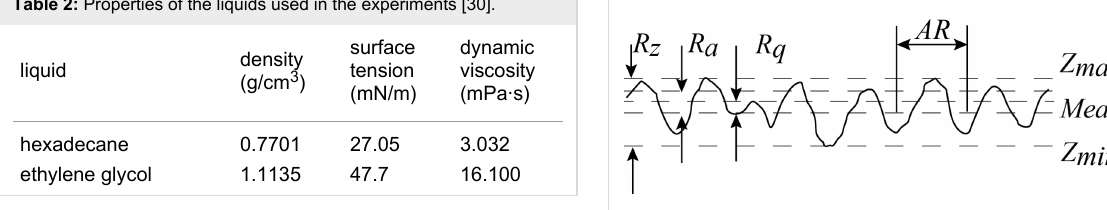
Labs) to a concentration of 45 mg·mL − 1 , then the solution was spray-coated to form a functional layer (thickness ca. 30 nm).